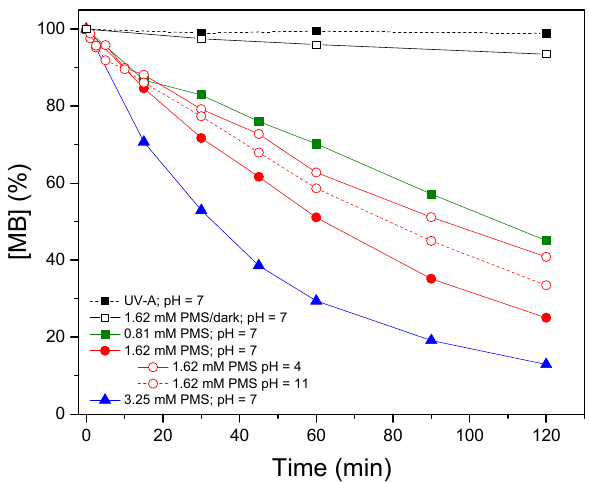
Figure 1. Influence of peroxymonosulfate (PMS) dosage (0.81, 1.62 and 3.25 mM), and pH (4, 7 and 11) in methylene blue (MB) discolouration, through PMS photoactivation with UV-A radiation.